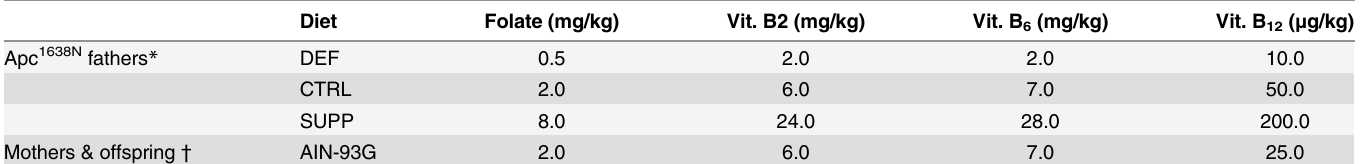
Table 1. B vitamin composition of parental and offspring diets.